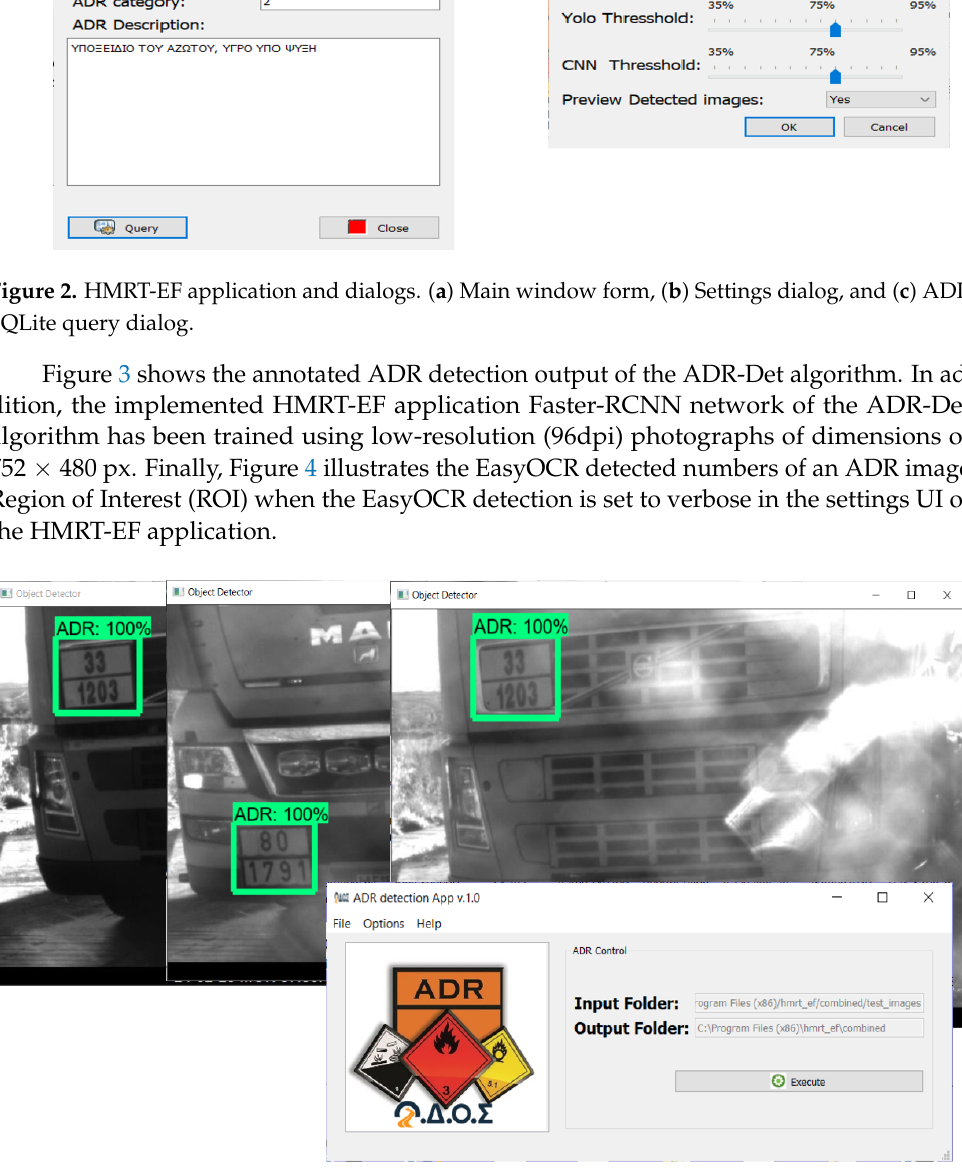
Figure 3. HMRT-EF execution process with its preview capabilities enabled displaying the detected Regions of Interest (ADR sign—green rectangular box) for each detected track carrying danger- ous